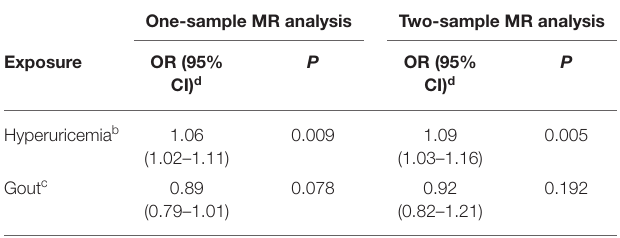
TABLE 3 | Association of hyperuricemia and gout with risk of cardiovascular disease (CVD) a using Mendelian Randomization (MR) analyses. One-sample MR analysis Two-sample MR